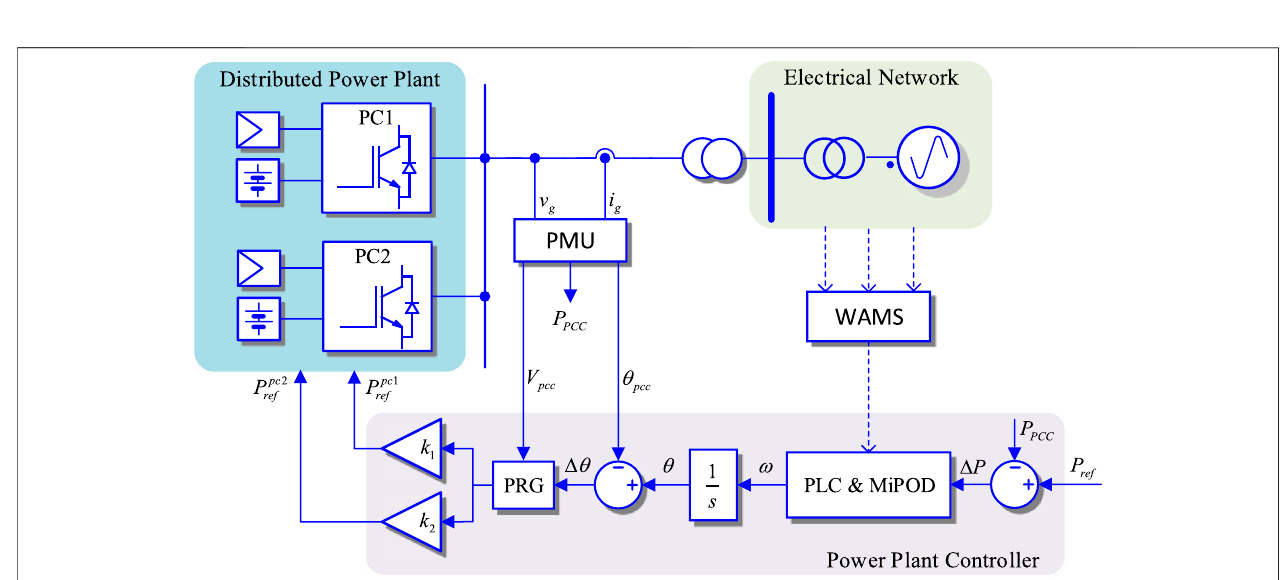
FIGURE 2 | Overall Structure of the proposed MiPOD for SPC-based grid forming power